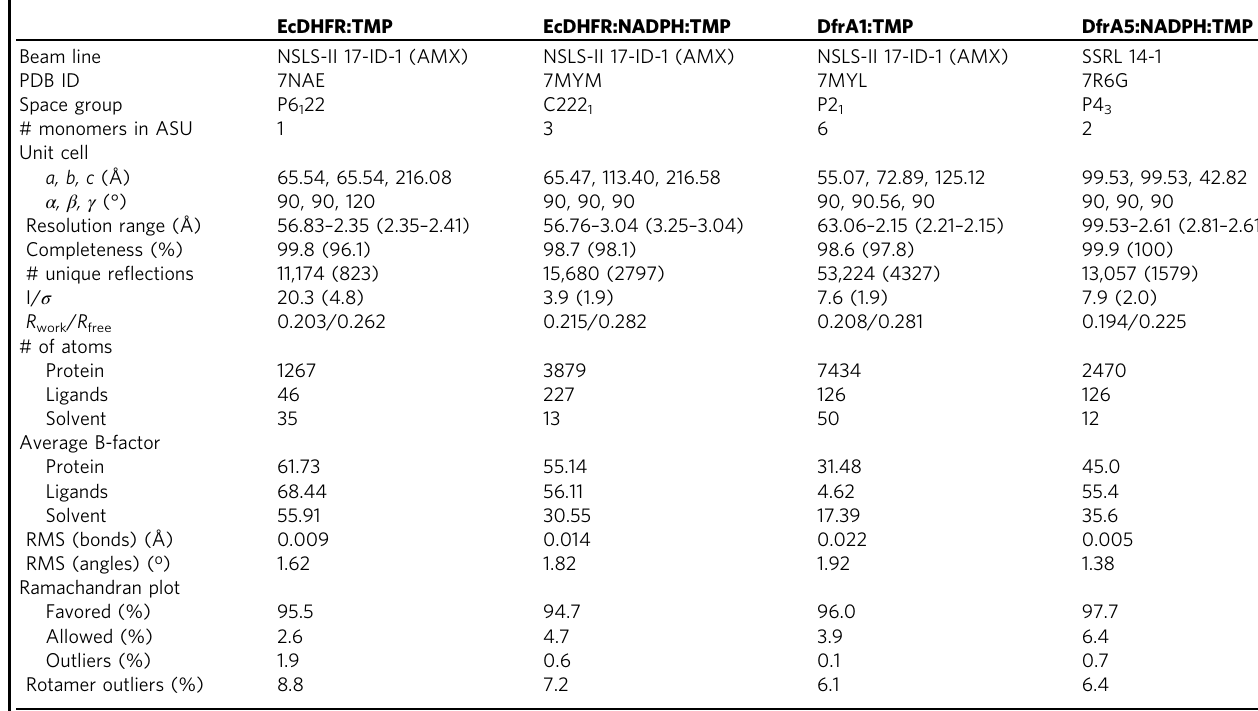
Values in parentheses are for highest-resolution